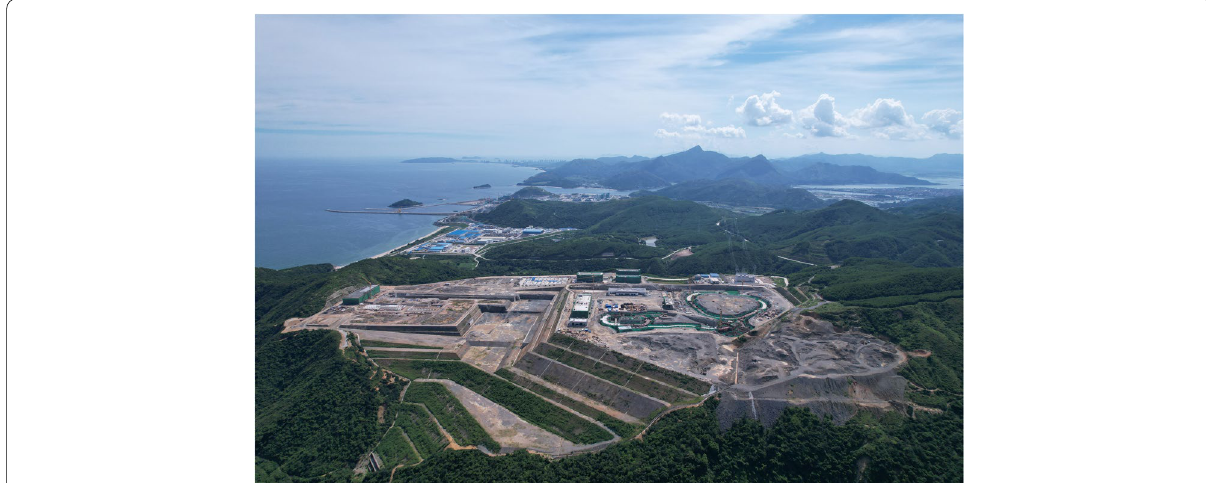
Fig. 1 Photo of HIAF construction site taken by an unmanned aerial vehicle in August of 2022. The profile of HIAF is visible. The China ADS facility is under construction on the same campus, located in the left area of the